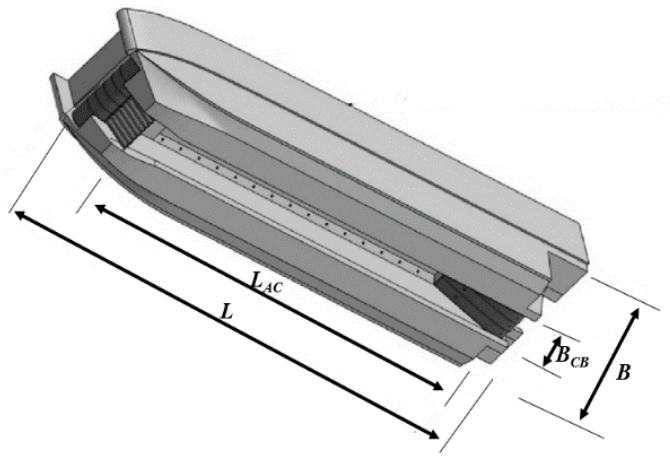
Figure 1. Model in towing test. ( a ) 3-D model of the Partial Air Cushion Supported Catamaran Model (PACSCAT); ( b ) Lines plan of the PACSCAT hull.